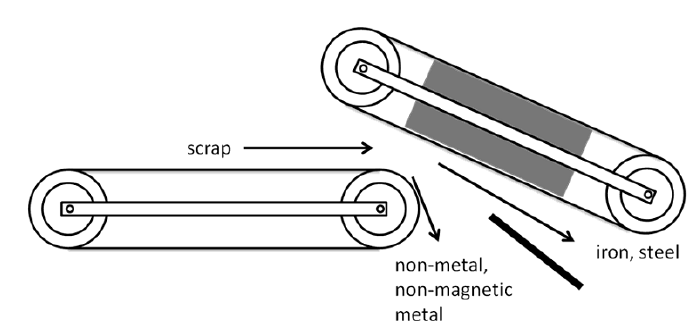
Figure 7. Overhead-belt magnetic